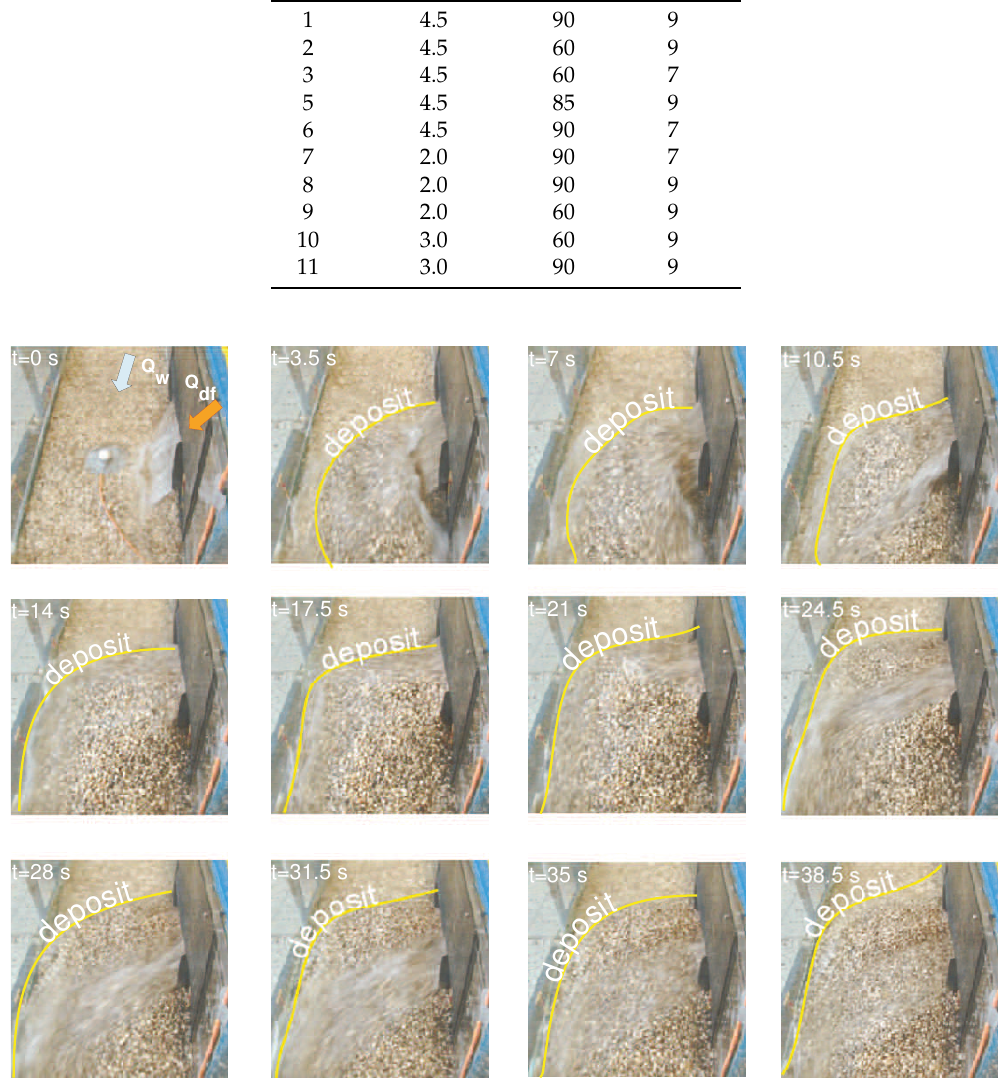
Figure 3. Temporal sequence of a debris flow injection from the tributary channel to the main channel. The contour of the deposited sediment is indicated with a yellow